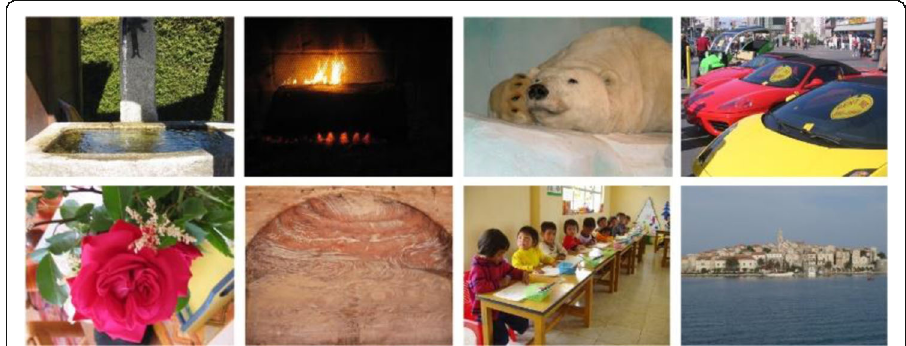
Fig. 15 Eight sample images (one per category) of the Holidays image dataset